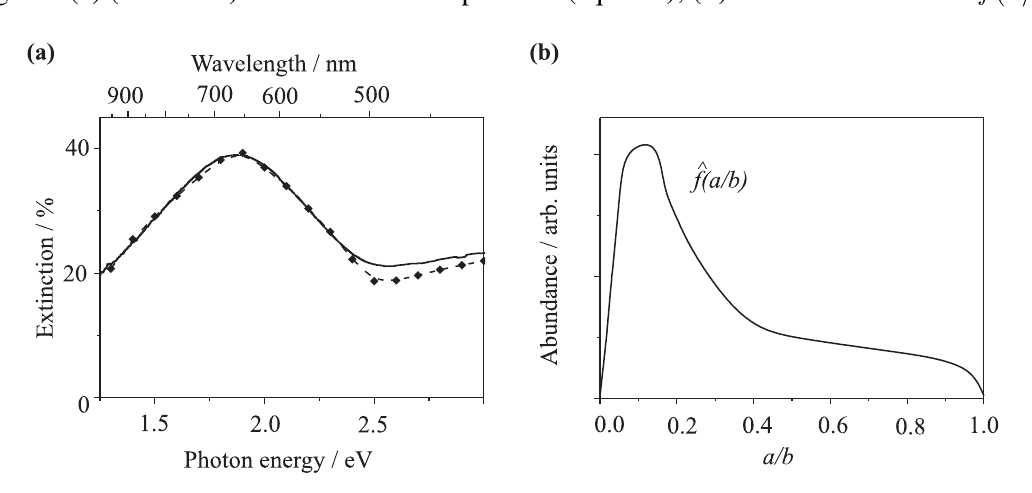
Figure 5. ( a ) Optical extinction spectrum of the gold nanoparticle ensemble depicted in Figure 1(a) (solid line) and the modeled spectrum (squares); ( b ) Calculated function ˆ f ( a/b )